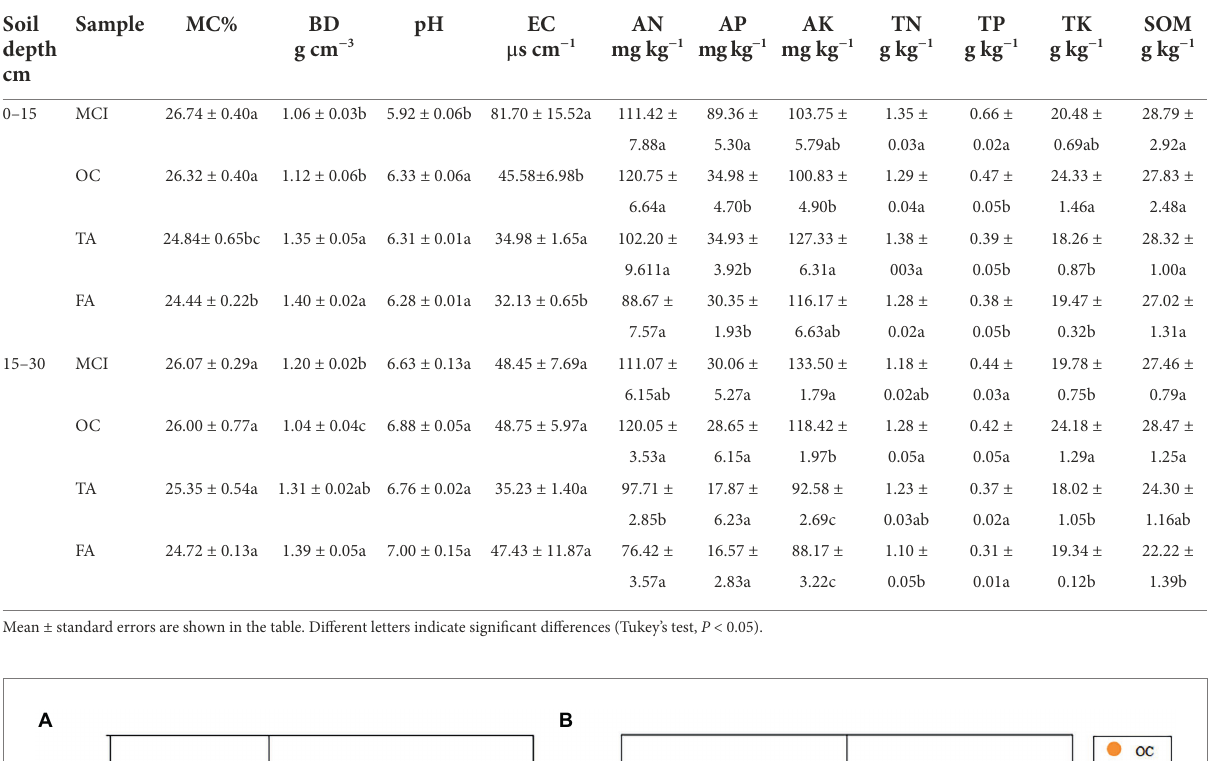
TABLE 1 Effect of planting practices on soil physicochemical properties.